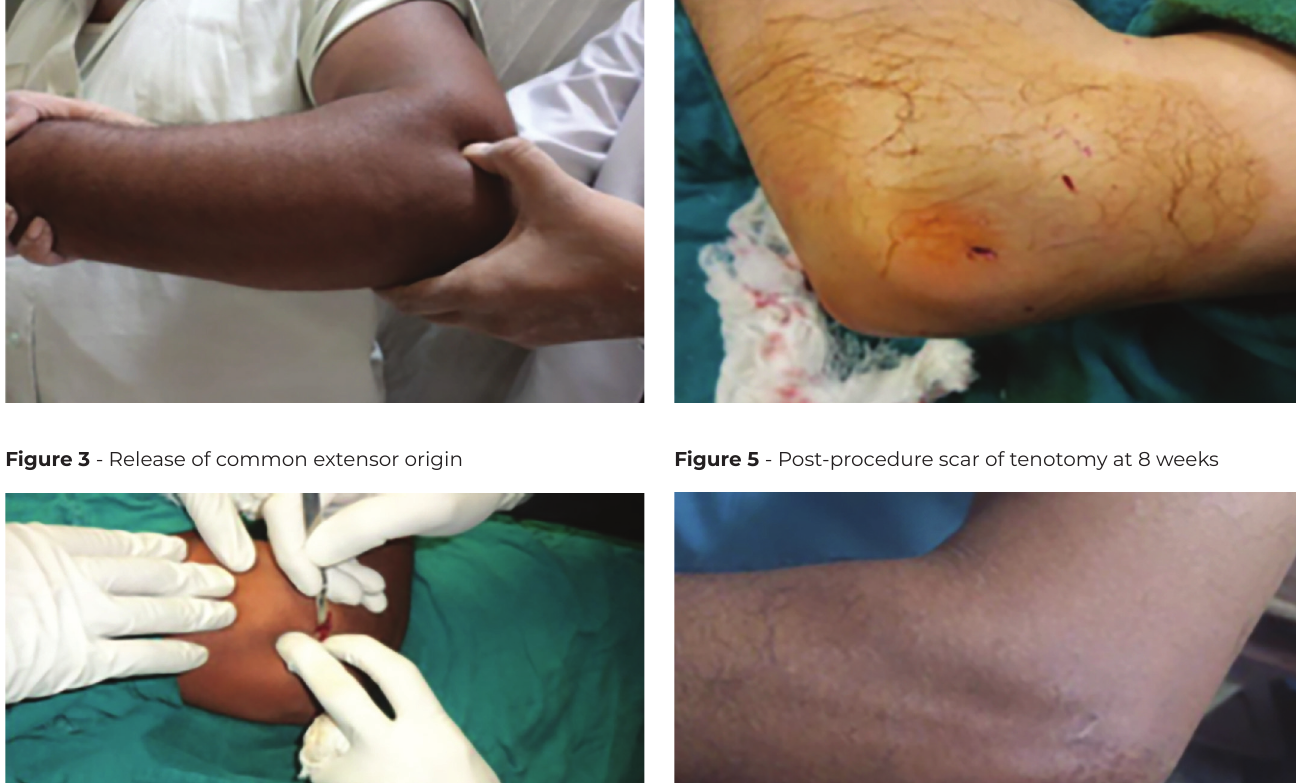
Figure 4 - Completion of the tenotomy